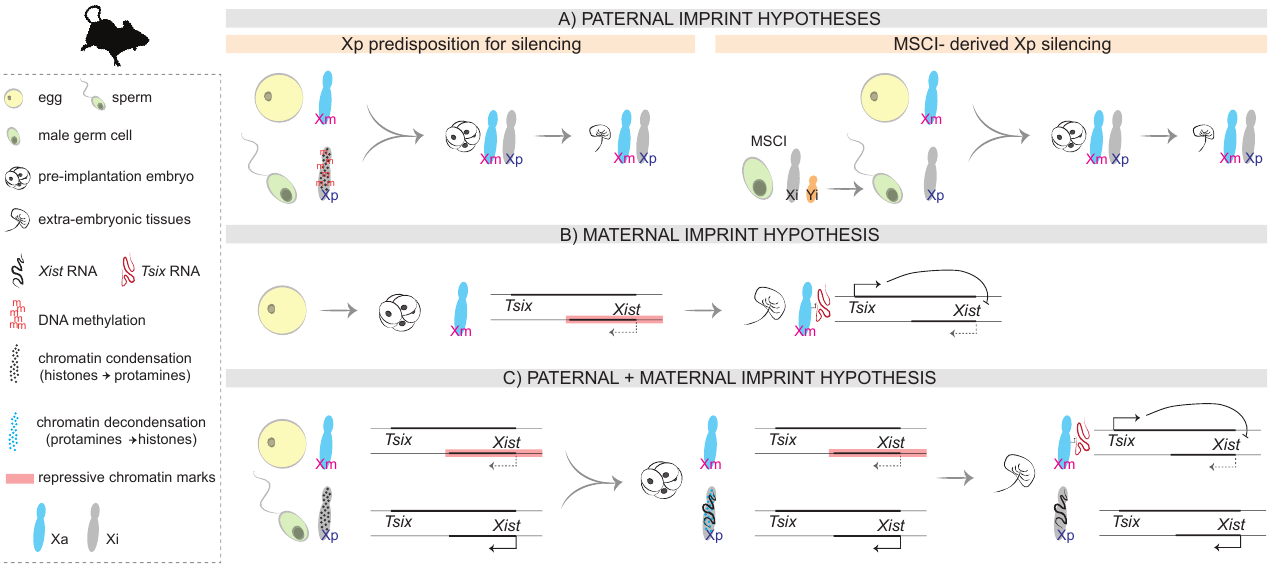
Figure 2. Hypotheses on the molecular nature of the imprint in mice. ( A ) Paternal imprint: The Xp inherits a predisposition for silencing from its life cycle in the male. ( B ) Maternal imprint: In the preimplantation embryo, repressive chromatin marks on the Xm (including the Xist promoter region) prevent Xist expression on the Xm. In the extra-embryonic tissues of the post-implantation embryo, Tsix expression prevents Xist upregulation in cis . ( C ) Paternal and maternal imprint: A combination of both hypotheses, considering the different chromatin condensation states of the Xp in the sperm and in the paternal pronucleus after